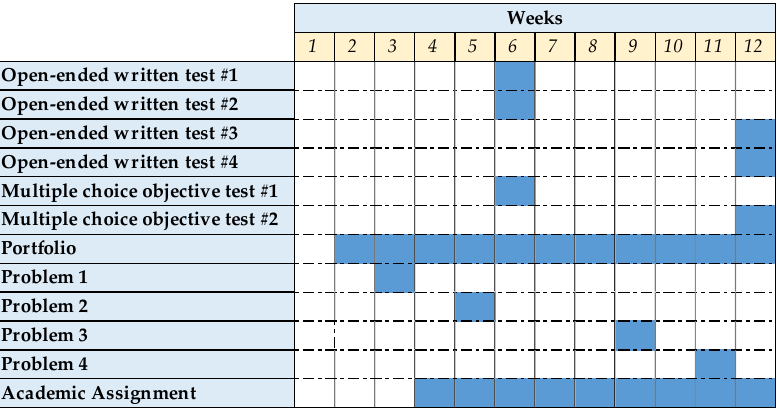
Figure 2. Schedule of evaluation techniques during the course on energy markets.